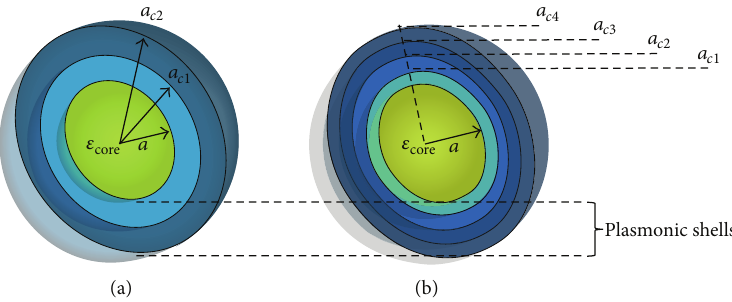
Figure 1: Geometry of composite nanoparticles consisting of (a) two and (b) four plasmonic layers, respectively. The core is made of dielectric